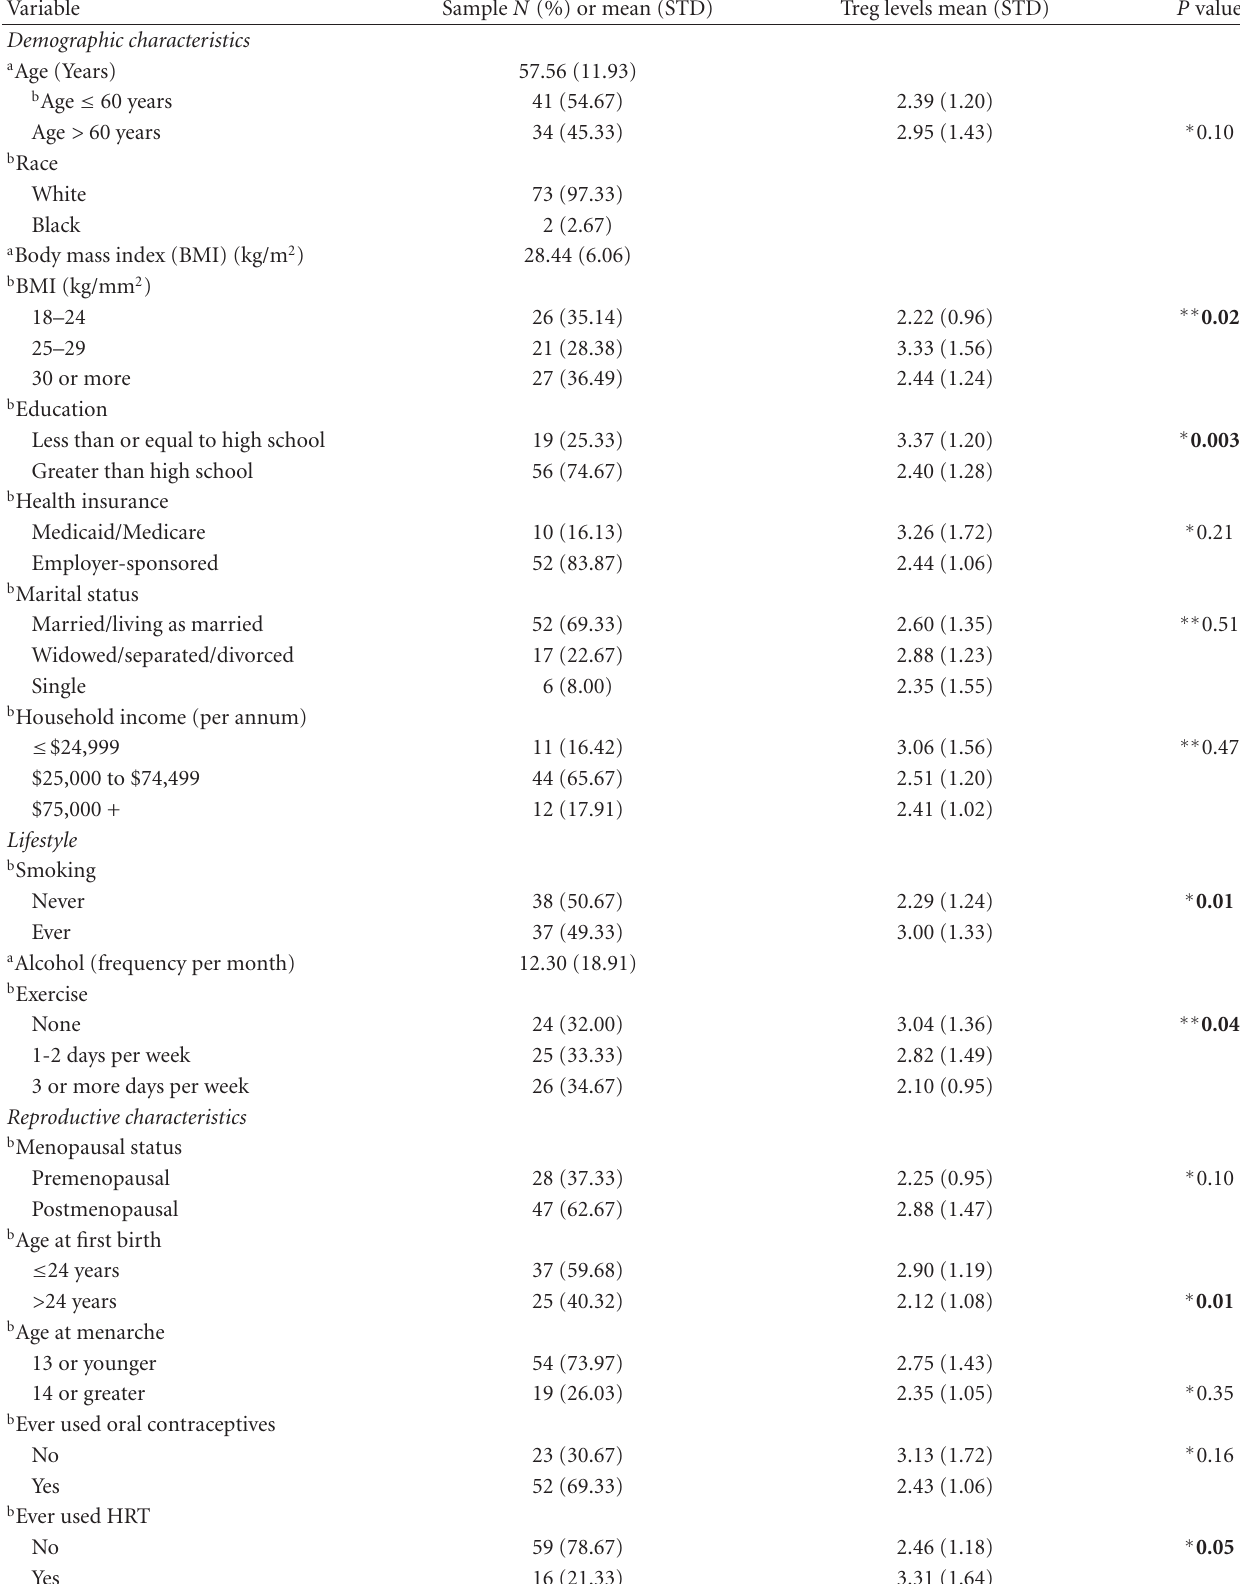
Table 1: Mean regulatory T-cell (Treg) levels across categories of demographic, lifestyle, diet, medication use, and